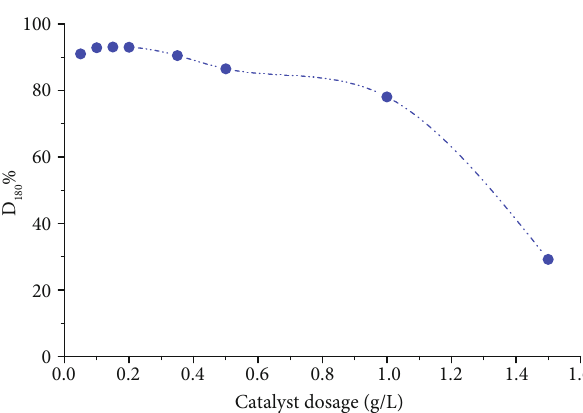
Figure 13: E ff ect of H using ð MNZ/Fe Þ = 0 : 2 g/L as